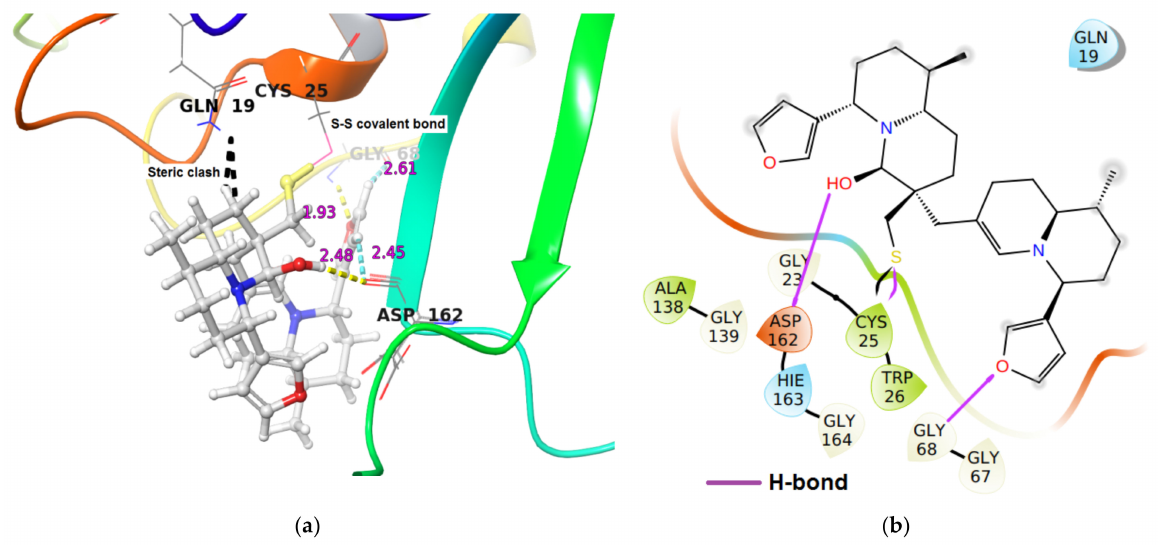
Figure 8. ( a ) 3-D representation of intermediate DTBN (iDTBN) docked to Cathepsin L. H-bond interaction is displayed by yellow dotted lines, C-H ... O hydrogen bonds are displayed by cyan blue dotted lines, steric clashes are displayed by black dotted line, ( b ) 2-D Ligand interaction diagram of iDTBN docked to Cathepsin